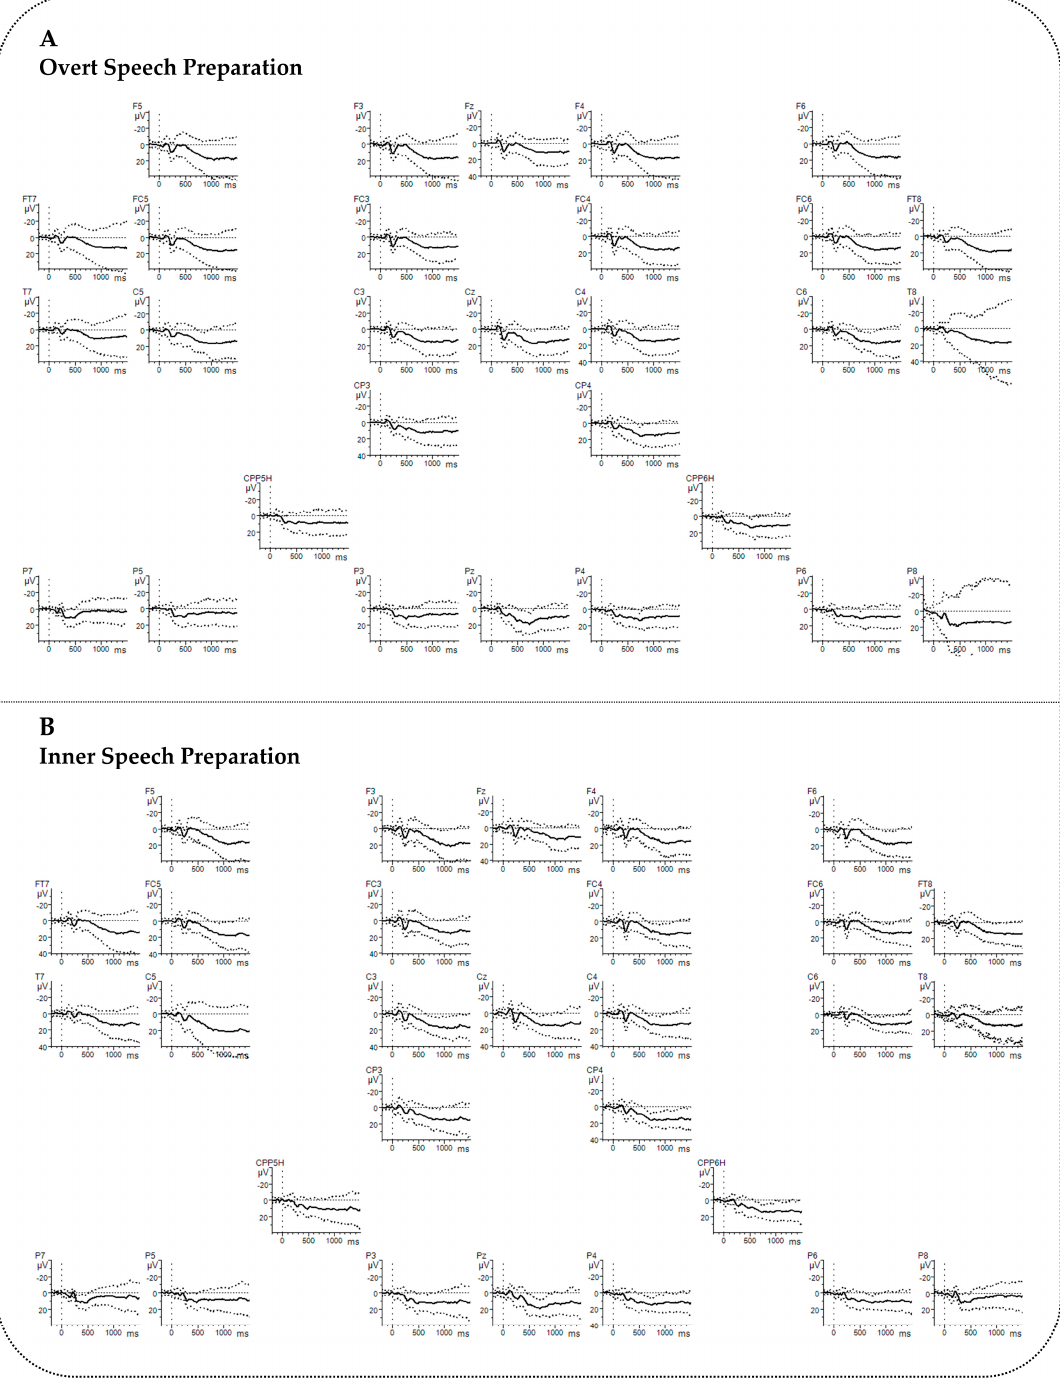
Figure A5. Event-related brain potentials (ERPs) for the Preparation phase including standard deviations. ( A ) Grand averages for the Overt Speech Preparation ( B ) Grand averages for the Inner Speech Preparation. Negative polarity is plotted upward. The x-axis ranges from − 200 to 1500 ms. No low-pass filter was applied for presentation